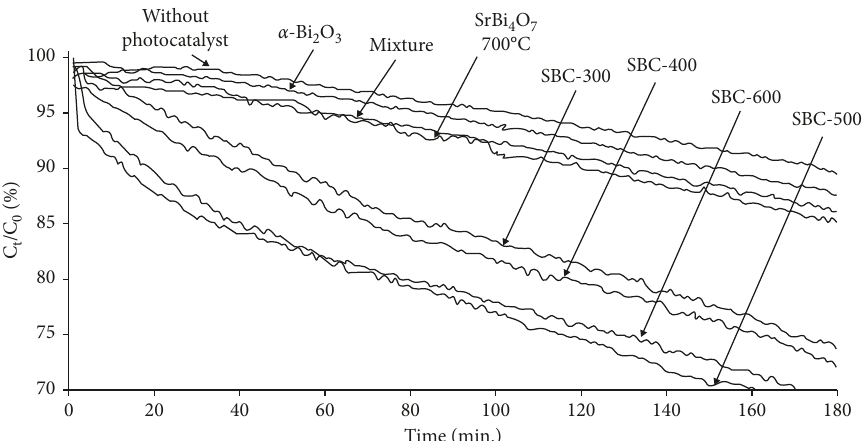
Figure 4: Photocatalytic decomposition curves of MB under irradiation with visible light in the presence of SBC-300, SBC-400, SBC-500, and SBC-600 and single-phase samples of SrBi 4 O 7 , and α -Bi 2 O 3 and a mechanical mixture of 73% SrBi 4 O 7 +27% (BiO) 2 CO 3 .